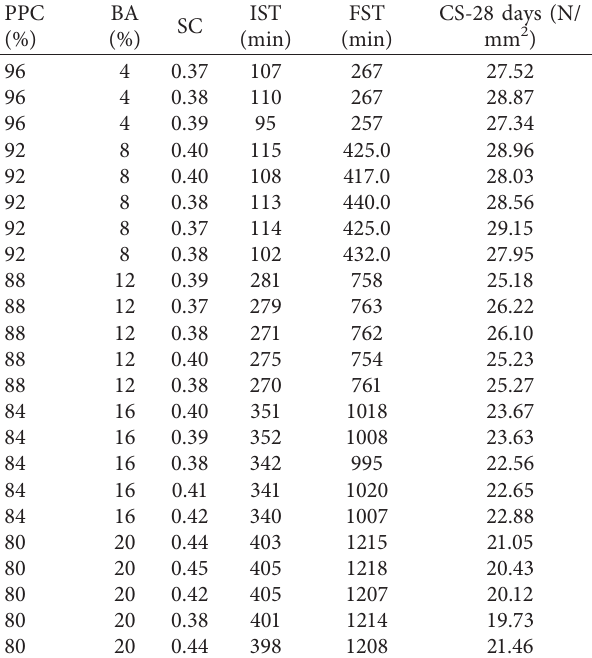
Table 1: Training datasets for ANN1-BA replacement.